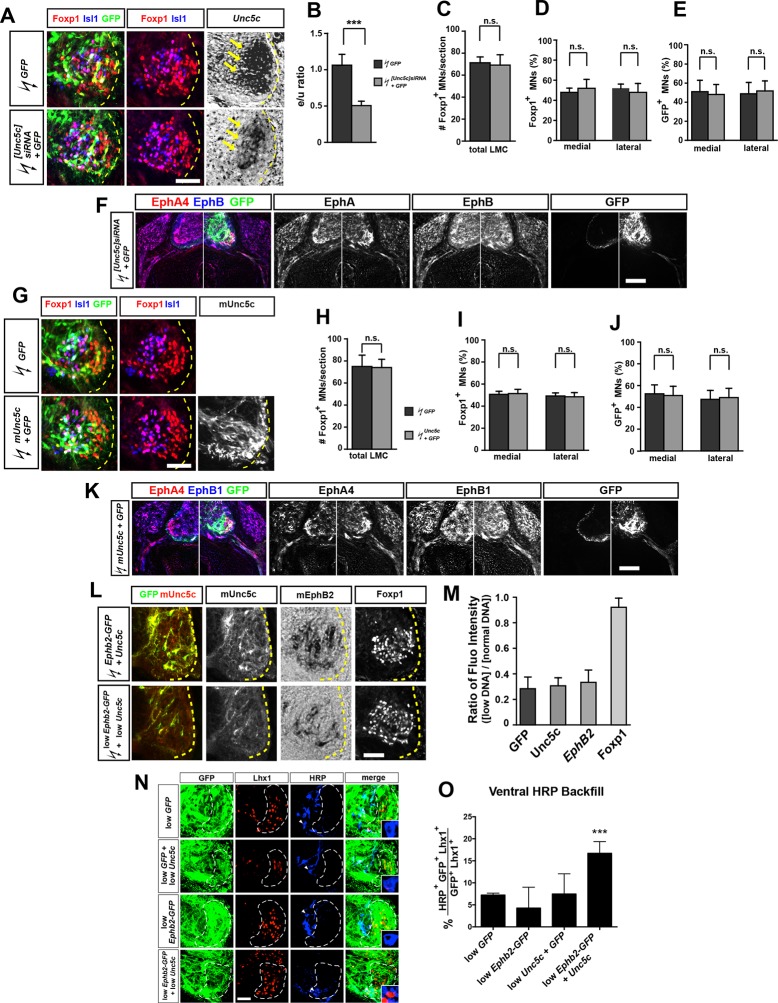
Characterization of siRNA-mediated Unc5c knockdown and Unc5c overexpression in LMC neurons in chicken.(A) Detection of Isl1, Foxp1, GFP, and Unc5c in chick embryos electroporated with [Unc5c]siRNA and GFP. (B) Quantification of the reduction in expression levels of Unc5c in LMC neurons after in ovo electroporation of [Unc5c]siRNA. Note a significant decrease (p<0.001) in Unc5c expression levels by 50% upon [Unc5c]siRNA and GFP but not GFP-only electroporation. Number of embryos quantified: n = 3 for both groups. (C, D) The total number of LMC neurons and the proportion of medial and lateral LMC are normal after [Unc5]siRNA electroporation. Number of embryos quantified: n = 4 for all groups. (E) Equal proportion of medial and lateral LMC neurons electroporated with either GFP only or [Unc5c]siRNA and GFP. Number of embryos quantified: n = 4 for all groups. (F) The expression of EphA4 and EphB1 is not altered after [Unc5]siRNA electroporation. (G) Detection of Isl1, Foxp1, GFP, and mouse Unc5c in chick embryos expressing mUnc5c and GFP. (H, I) The total number of LMC neurons and the proportion of medial and lateral LMC are normal after mUnc5c and GFP electroporation. Number of embryos quantified: n = 4 for all groups. (J) Equal proportion of medial and lateral LMC neurons electroporated with either GFP only or mUnc5c and GFP. Number of embryos quantified: n = 4 for all groups. (K) The expression of EphA4 and EphB1 is not altered after mUnc5c and GFP electroporation. Number of embryos quantified: n = 4 for all groups. (L) Detection of GFP, mUnc5c, mEphb2, and Foxp1 in chick embryos expressing normal (top) or low (1/5th) (bottom) concentrations of Ephb2-GFP and Unc5c plasmids. (M) Quantification of the ratio of the ectopic expression levels of low and normal concentration of GFP, Unc5c, and EphB2 in chick embryos. Number of embryos quantified: n = 6 for all groups. (N) Analysis of lateral LMC motor axon projections in chick embryos electroporated with Unc5c, Ephb2, Unc5c and Ephb2, or GFP expression plasmids (all at low concentrations). A retrograde tracer (HRP, blue) was injected in the ventral forelimb of HH st. 29/30 chick embryos followed by detection of Lhx1 (red) to identify lateral LMC neurons. Insets show examples of magnified HRP+ backfilled cells that are Lhx1+ (in low Unc5c + low Ephb2 co-electroporation) or Lhx1- (in all other conditions). (O) Quantification of retrogradely labeled lateral LMC axon projections. The graph depicts the mean percentage ± SD of electroporated (GFP+) and HRP+ backfilled motor neurons that express the lateral LMC marker Lhx1 after a ventral limb injection. N ≥ 3 embryos. HRP, horseradish peroxidase; LMC, lateral motor column; error bars = SD; *** = p<0.001; n.s. = not significant; statistical significance computed using Mann-Whitney U test (B–E, H–J, M), or Fisher’s exact test on raw numbers (O); all values are mean ± SD. Scale bars: (A, G, L) 56 μm; (F, K) 145 μm; (N) 40 μm.